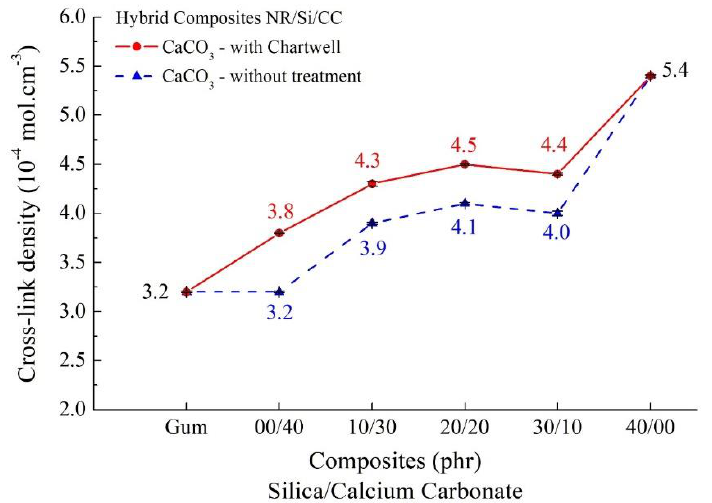
Figure 7. Crosslink density of the hybrid composites of NR with silica (SiO 2 + Si69 ® ) and carbonate of calcium (CaCO 3 ) treated with 2% Chartwell ® . Said density was calculated using the Flory–Rehner swelling equation (mass ≈ 0.25 ± 0.05 g, immersed in toluene for 5 days, then placed in the oven for 24 h at 60 °C). Gum was included as a reference point.